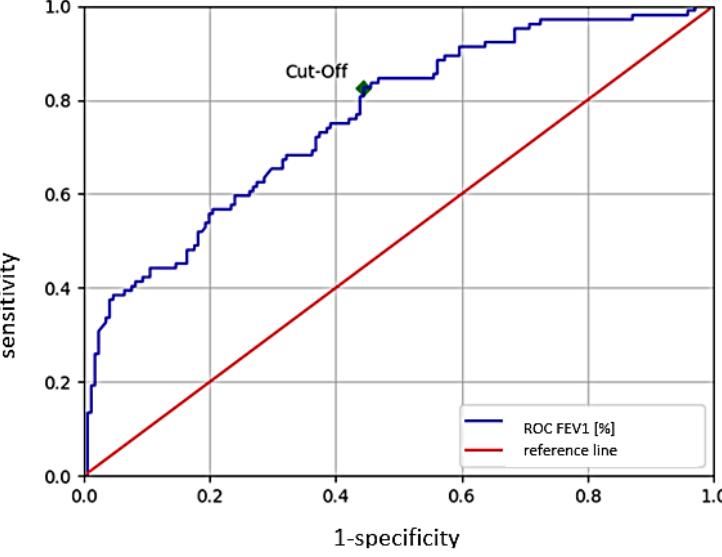
Figure 1. Receiver operating characteristic (ROC) curves of FEV1 [%], with a predicted cut off value of 41.12% with a sensitivity of 82.6% and specificity of